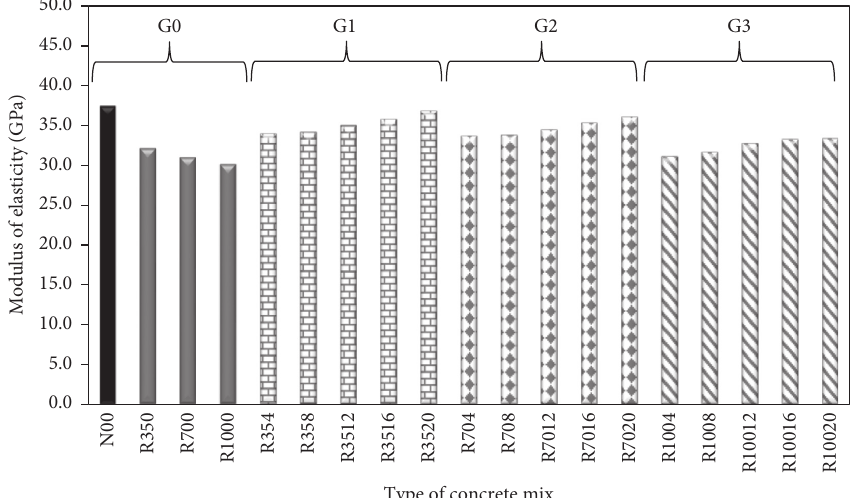
Figure 15: Modulus of elasticity after 28 days of curing.